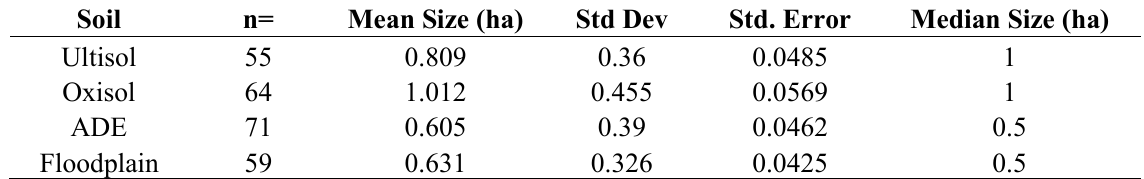
Table 3. Manioc field sizes in different soil types along the middle Madeira